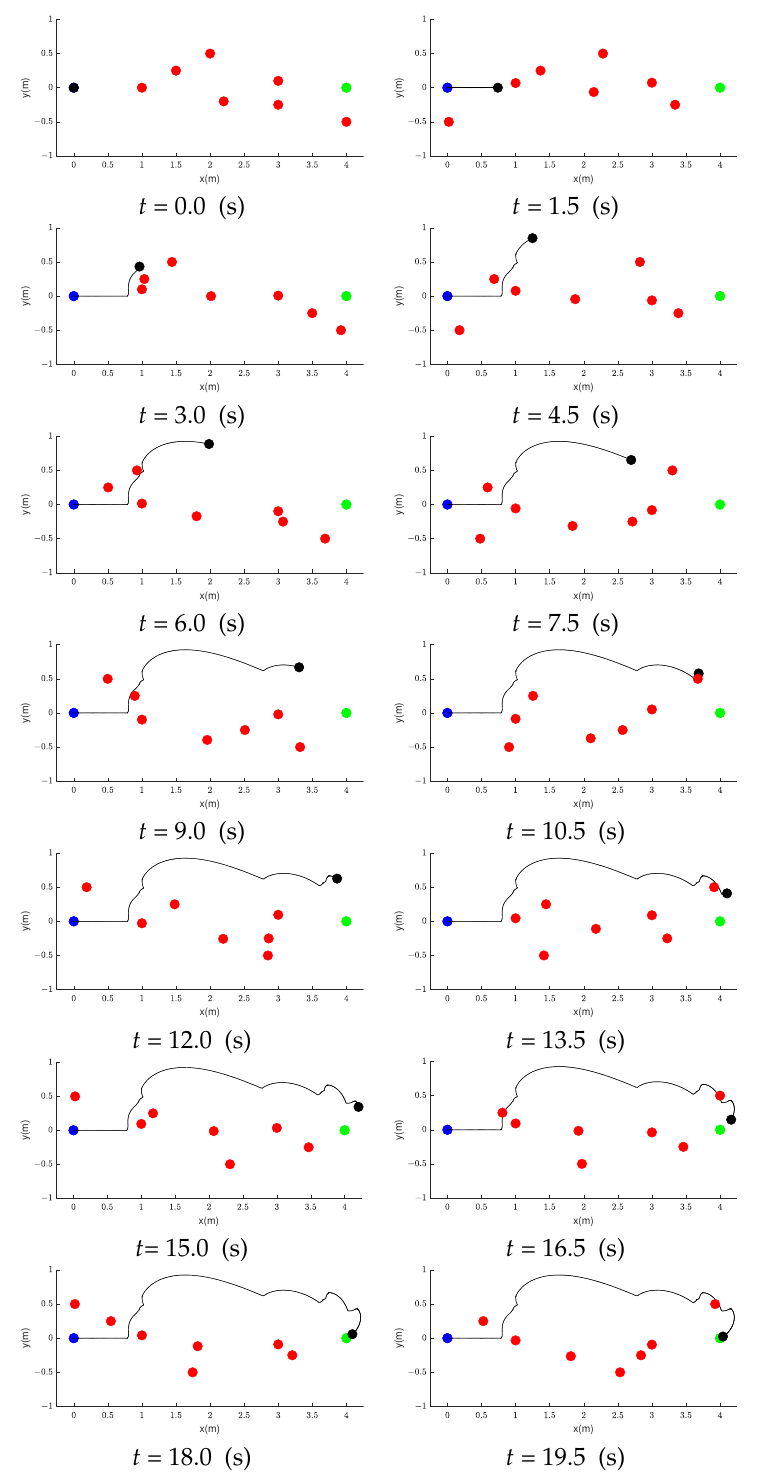
Figure 6. Behavior of Bug0 + for an arbitrary run. The complete scenario is shown every 1.5